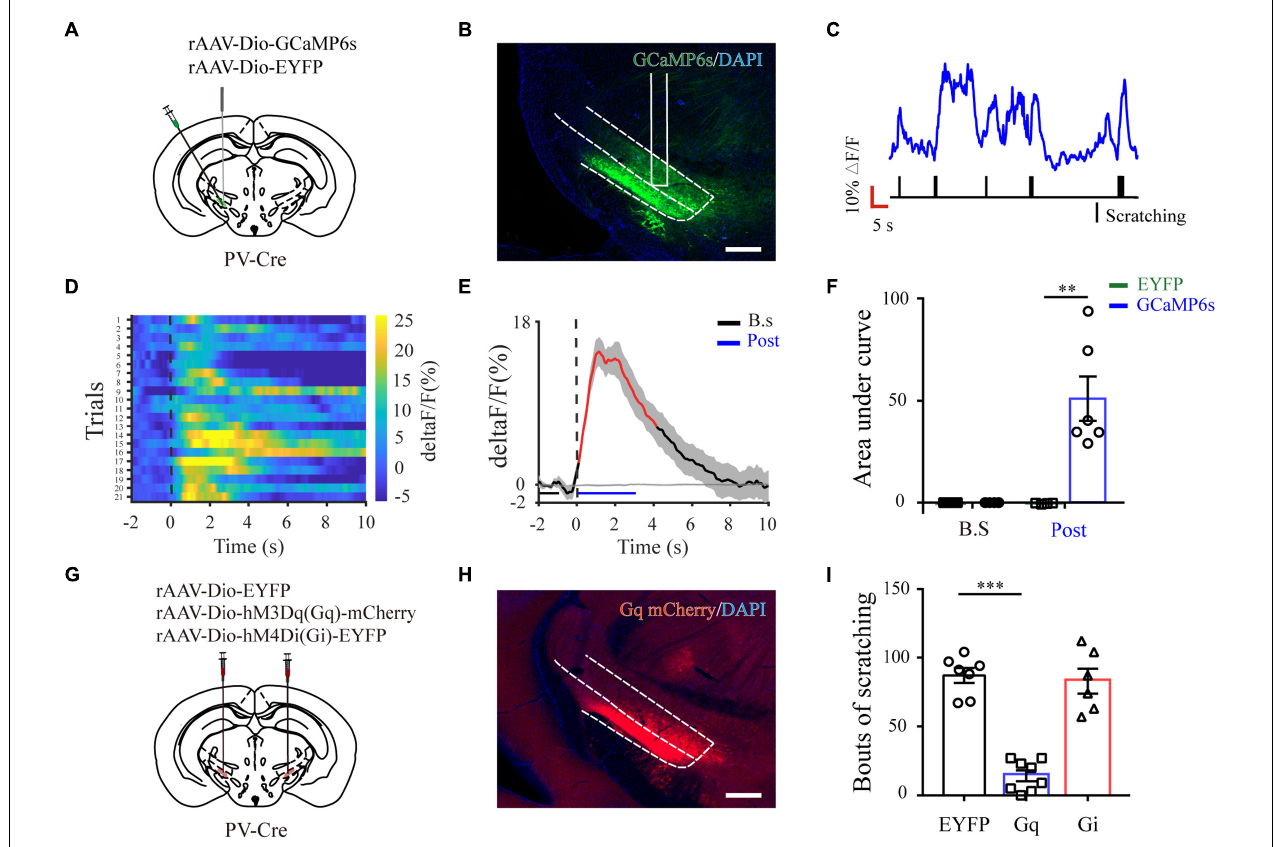
FIGURE 5 | ZI PV neurons negatively regulate scratching behaviors during chronic itch. (A) Schematic showing the viral targeting of AAV-DIO-GCaMP6s-EYFP and AAV-DIO-EYFP into the ZI of PV-Cre mice with AD. (B) Histological verification of viral expression (green) and optical fiber implantation in the ZI in a representative mouse. (C) Representative GCaMP6s fluorescence trace (top) and behavioral trace (bottom) recorded simultaneously in ZI PV neurons in response to calcipotriol injection. (D) Heatmap illustrating GCaMP6s fluorescence aligned to the beginning of individual scratching trains in all the mice in response to calcipotriol stimuli. Each row represents Ca 2 + signals corresponding to one scratching train. (E) Mean fluorescent signal in response to calcipotriol stimuli in all the mice recorded, with shaded areas indicating the SEM. The black and gray line represent the signals of PV ZI neurons in mice with AAV-GCaMP6s and AAV-EYFP injection, respectively. The red line represents statistically significant increase from the baseline ( P < 0.05; multivariate permutation test). (F) Area under the curve showing fluorescence changes of ZI PV neurons in mice with AAV-GCaMP6s and AAV-EYFP injection in both pre-scratching and post-scratching periods under the condition of calcipotriol stimuli. Repeated ANOVA followed by simple effects analysis. n = 4 mice in EYFP group and 6 mice in GCaMP6s group, F (1,8) = 14.355, P < 0.01. (G) Schematic illustration of viral injection in mice with AD for chemogenetic modulation of ZI PV neurons. (H) Histological verification of viral expression within ZI in a representative mouse with AAV-DIO-hM3Dq-mCherry injection. Scale bar = 250 µ m. (I) Chemogenetic activation of ZI PV neurons reduces scratching behaviors induced by calcipotriol injection, while the inhibition of them exerts no effect on scratching behaviors. One-way ANOVA with post hoc LSD test for multiple comparisons. F (2,6) = 49.27, P < 0.001. n = 7, 8, and 6 in EGFP, hM3Dq, and hM4Di group, respectively. ∗∗∗ P < 0.001, ∗∗ P <